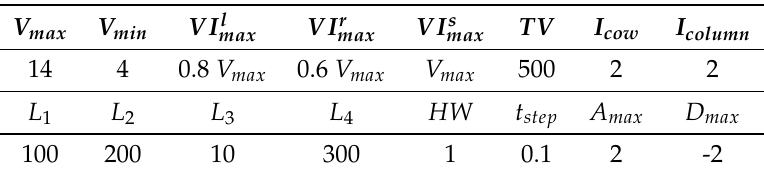
Table 4. Simulation